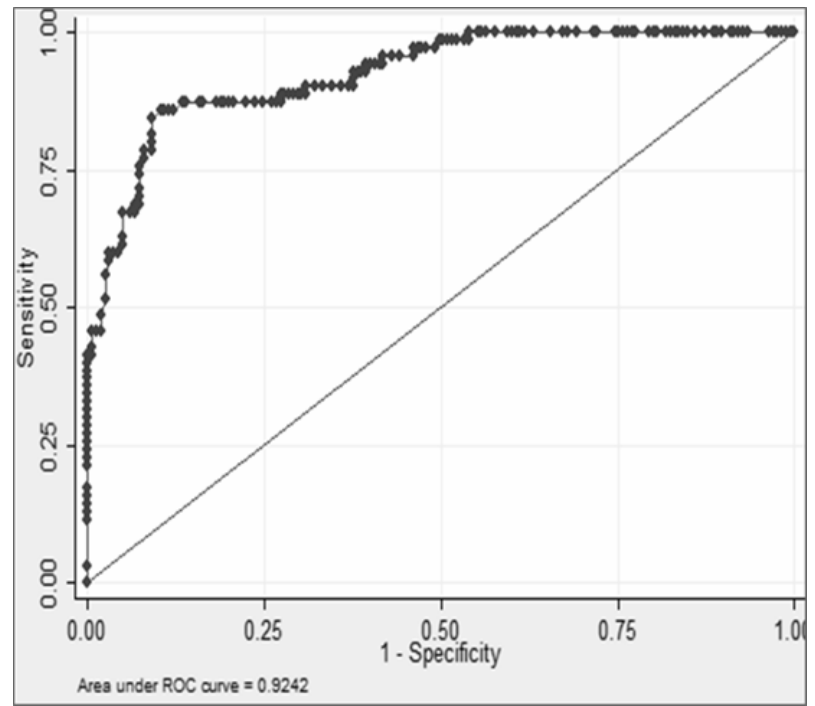
7 of 14 Figure 1. Boxplot characterization of the median galactomannan OD index values categorized using AspICU criteria.